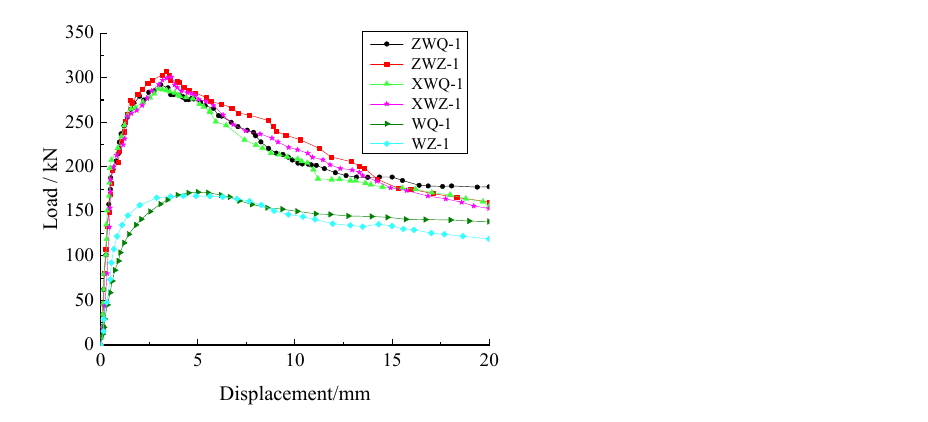
Figure 18. Load-displacement curves of brick walls under different forms of construction measure.